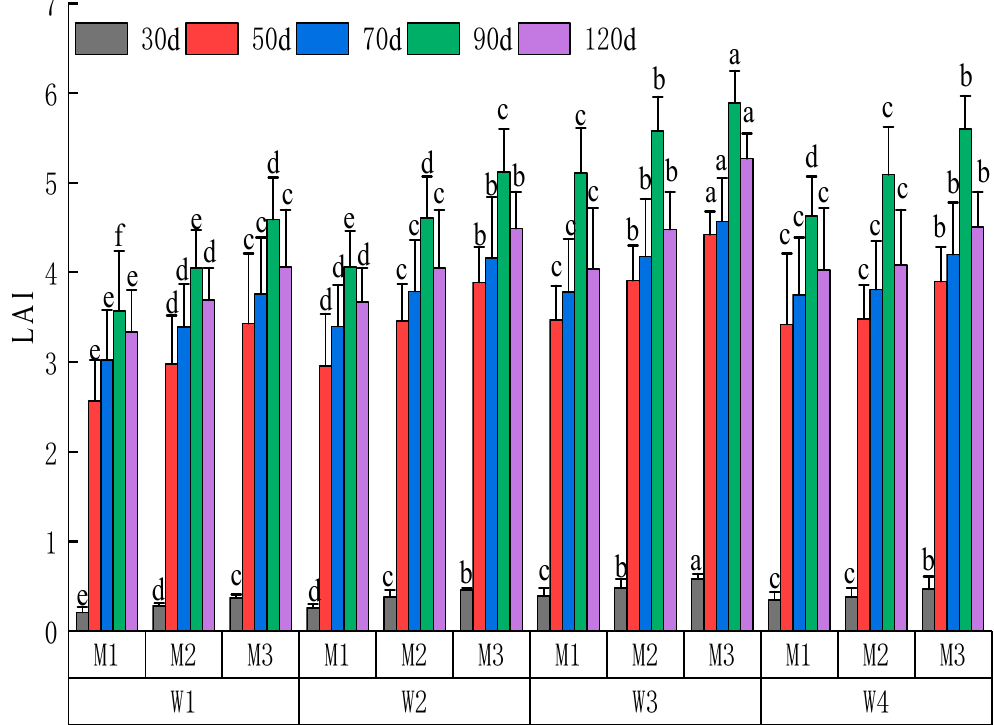
Figure 5. Changes of irrigation amount on the LAI of degradable film-covered drip-irrigated maize.